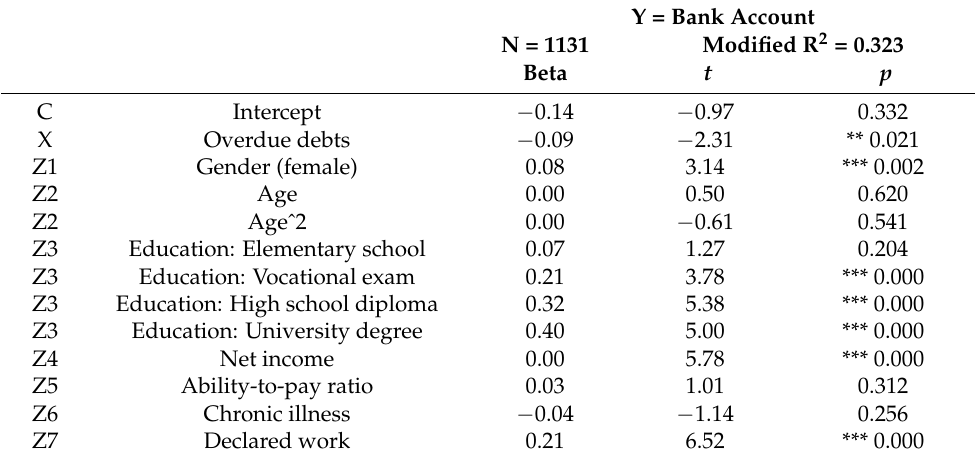
Table 4. Overdue debts and bank